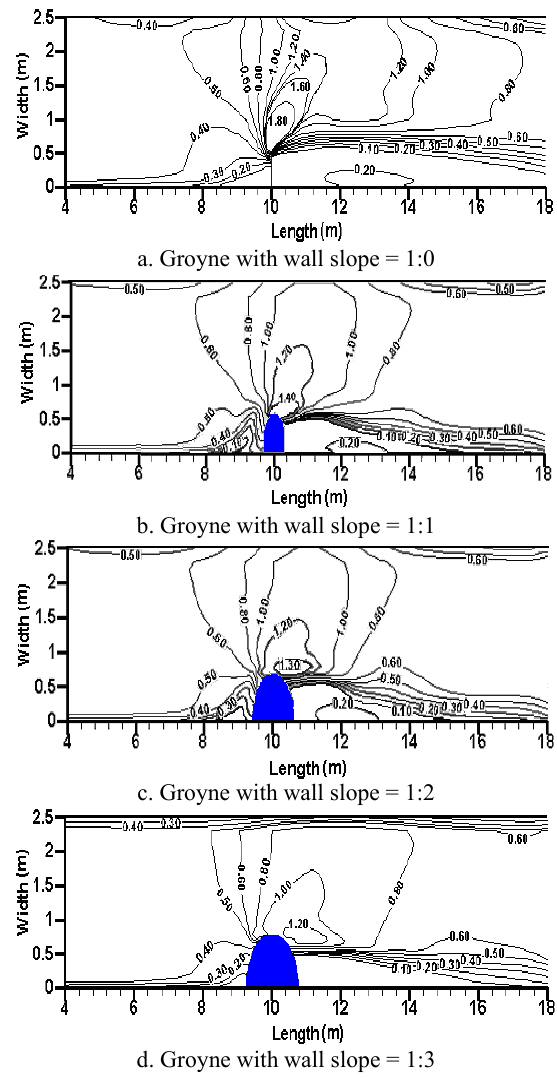
Fig.12 Isolines of bed shear stresses for the flat